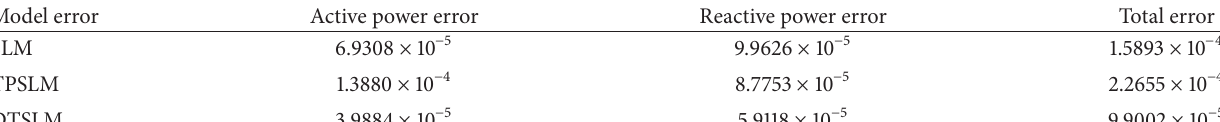
Table 11: Comparison of average error.